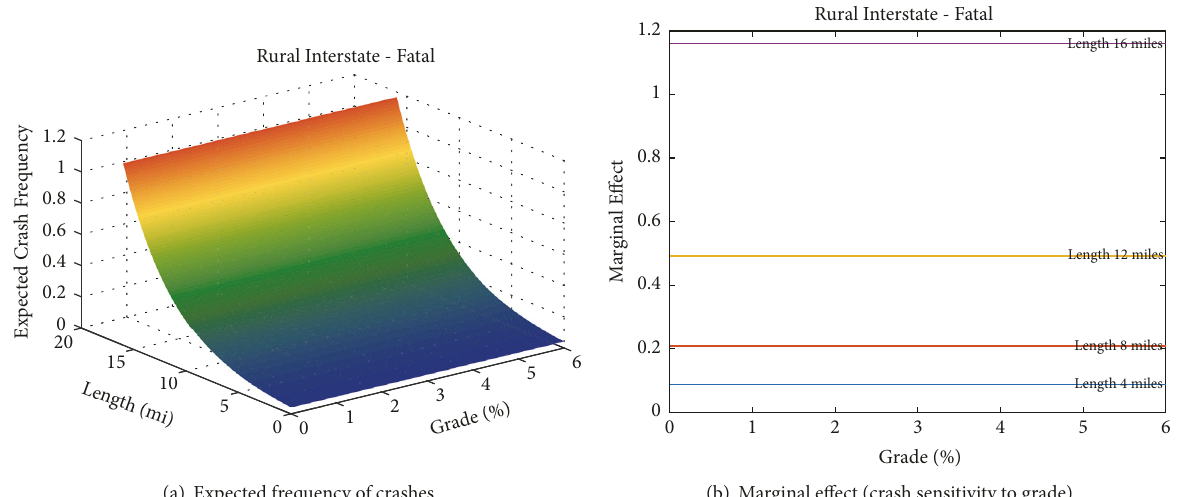
Figure 1: Rural interstate fatal crashes.